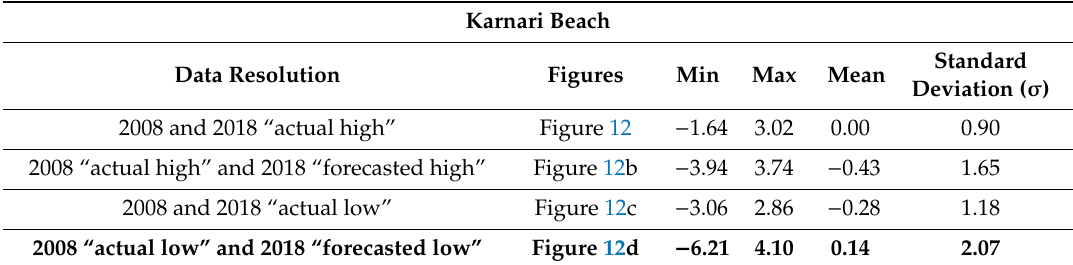
Table 5. EPR statistical rates (in meters /